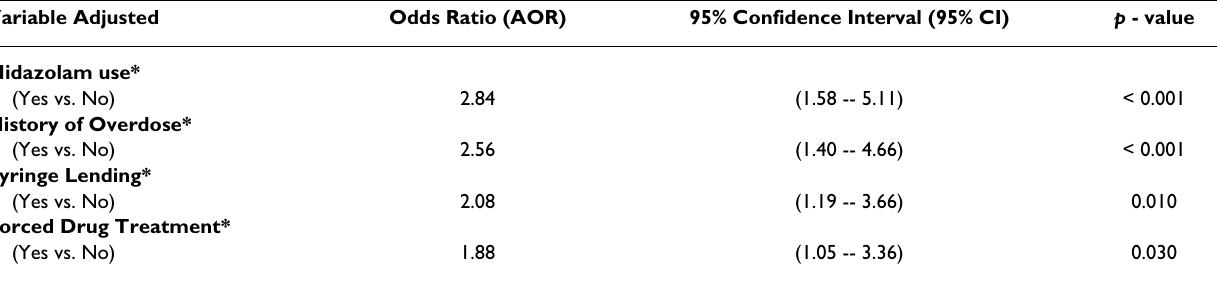
Table 2: Multivariate logistic regression analysis of factors associated with drug planting by police among Thai IDU (N =